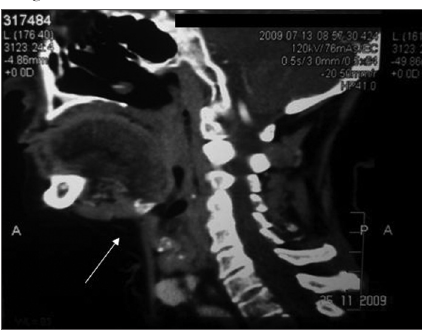
Figura 1. Leito operatório sem recidivas